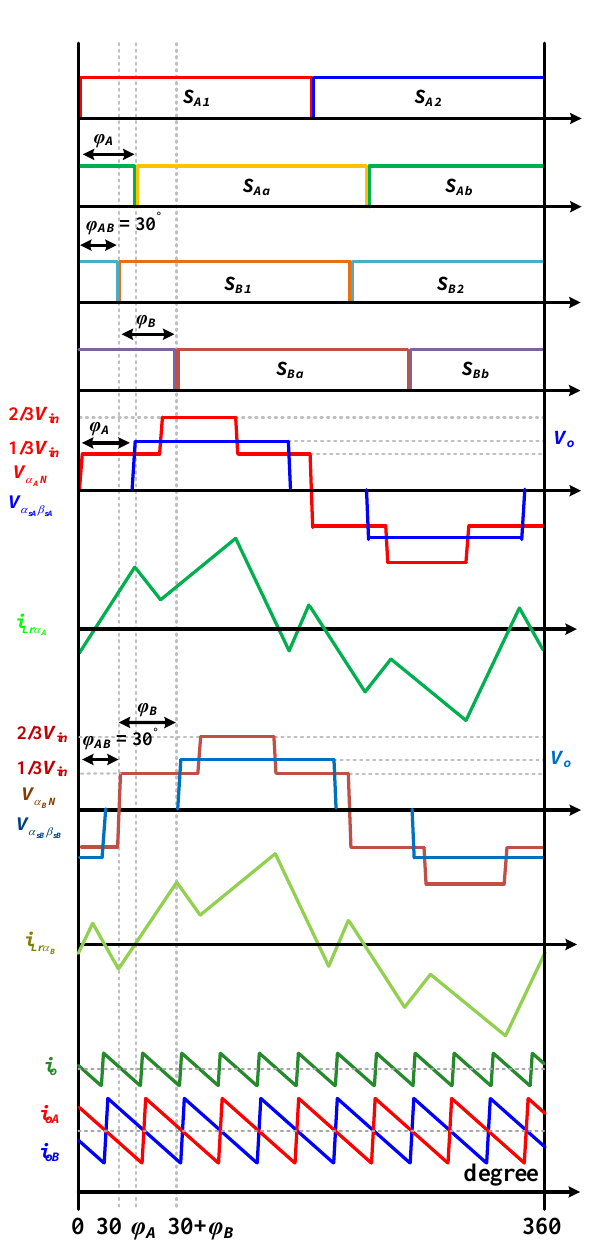
Figure 7. Operating principle of an interleaved three-phase series-resonant converters (SRC).